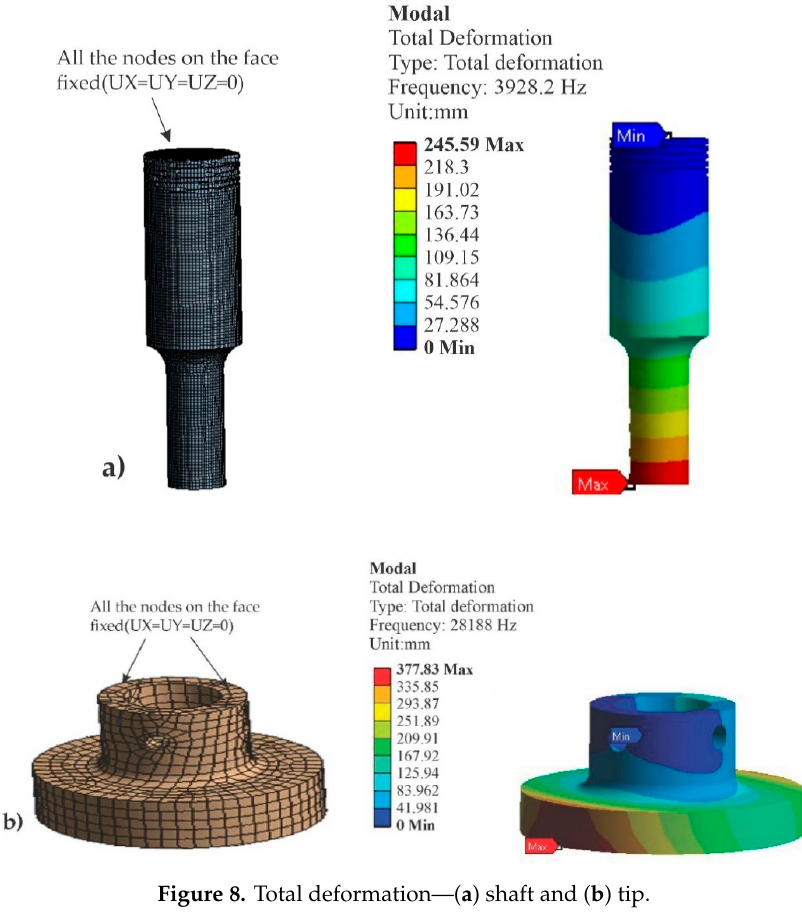
Figure 8. Total deformation—( a ) shaft and ( b ) tip.